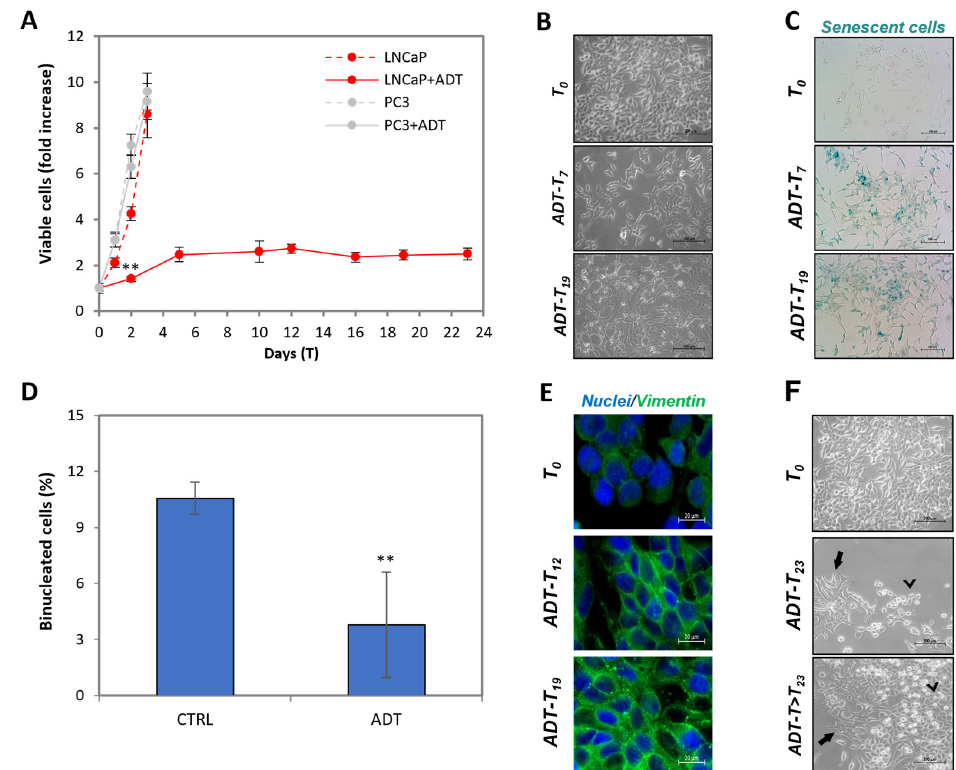
Figure 1. ADT induces cytostasis in the hormone-sensitive LNCaP cells. ( A ) Kinetics of viable (trypan blue-excluding) cell number expressed as fold over T0. Dashed lines indicate control cells. Statistical significance was calculated via Student’s t -test. ** p < 0.01, with respect to control cells. ( B ) Phase-contrast images of LNCaP during ADT at the indicated time points. The scale bar corresponds to 200 µ m. ( C ) β -galactosidase staining at T0, T7 and T19. The scale bar corresponds to 200 µ m. ( D ) Frequency of bi-nucleated cells at T5 of ADT with respect to control cells. Statistical significance was calculated via Student’s t -test. ** p < 0.01 respect to control cells. ( E ) Immunofluorescence with anti-vimentin antibody (green) and DAPI (blue) in wide-field micrography. The scale bar corresponds to 20 µ m. ( F ) Phase-contrast images of LNCaP after ≥ 23 days of ADT. Black arrows indicate cells surviving ADT, arrow heads indicate ADT-resistant clones. The scale bar corresponds to 200 µ m.